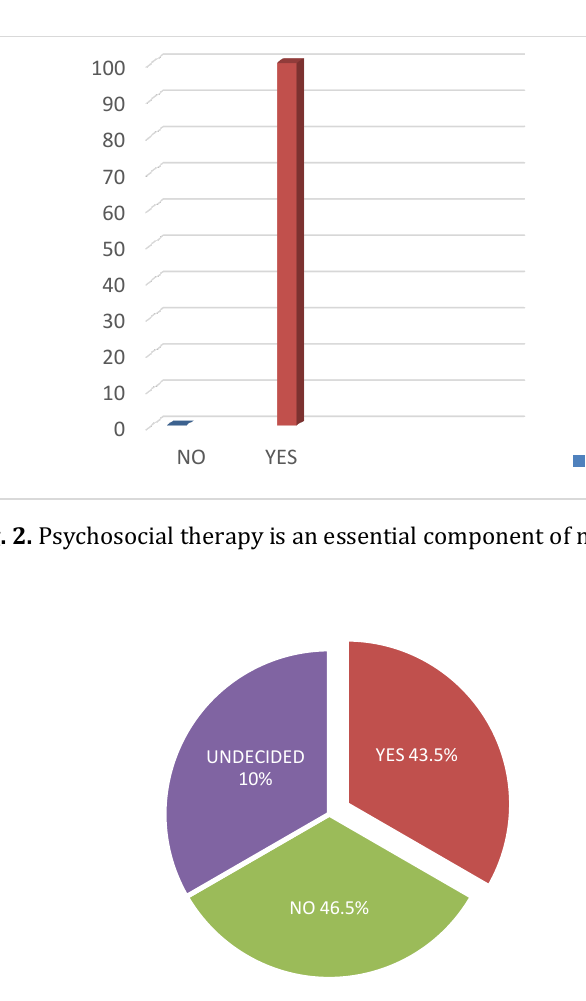
Fig. 3. Do mothers express confidence in the skills of the nurse in providing psychosocial care of the child with